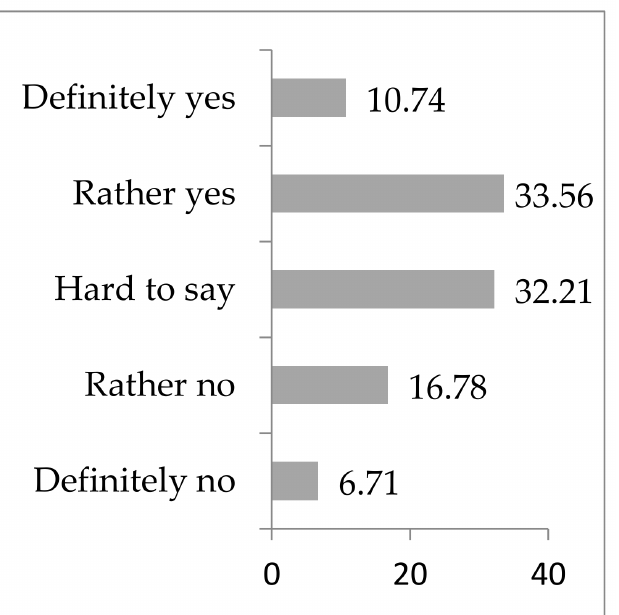
Figure 3. The occurrence of changes towards increased automation in the company in the opinions of employees.